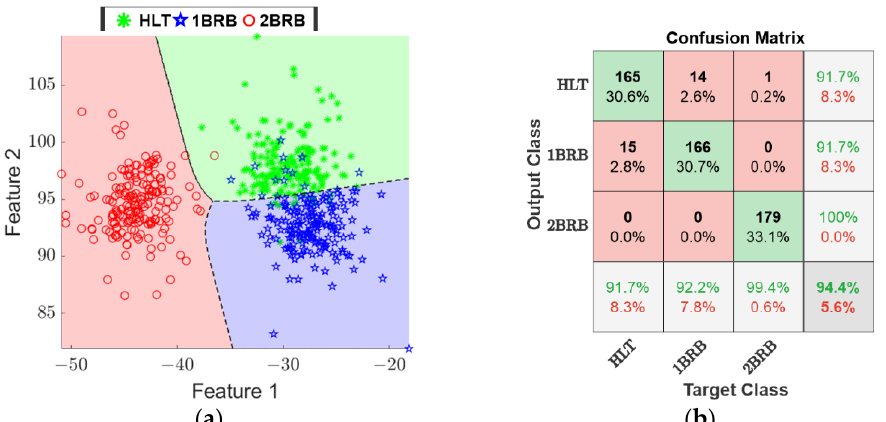
Figure 14. Classification results of the proposed methodology obtained for the Omron soft-starter. ( a ) Resulting decision regions modelled by the proposed NN-based classifier over the 2-dimensional space; ( b ) Confusion matrix.